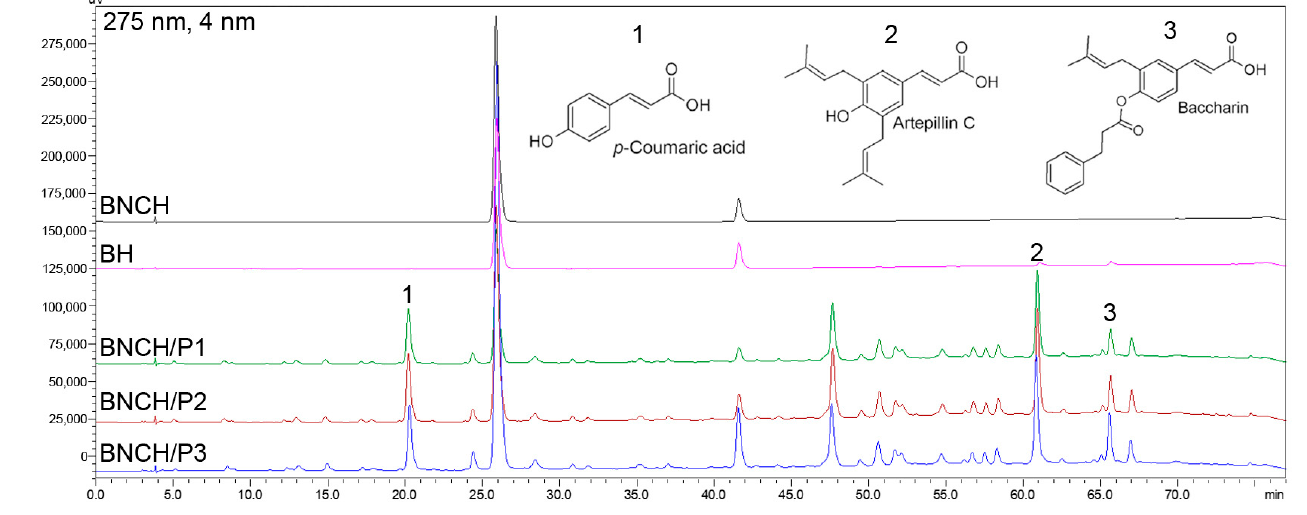
Figure 3. Chromatographic profile of hydrogels: ( 1 ) p -coumaric acid, ( 2 ) artepillin C, and ( 3 ) baccharin. Table 1. Chemical composition of EPP-AF ® biomarkers in propolis hydrogels (average ±